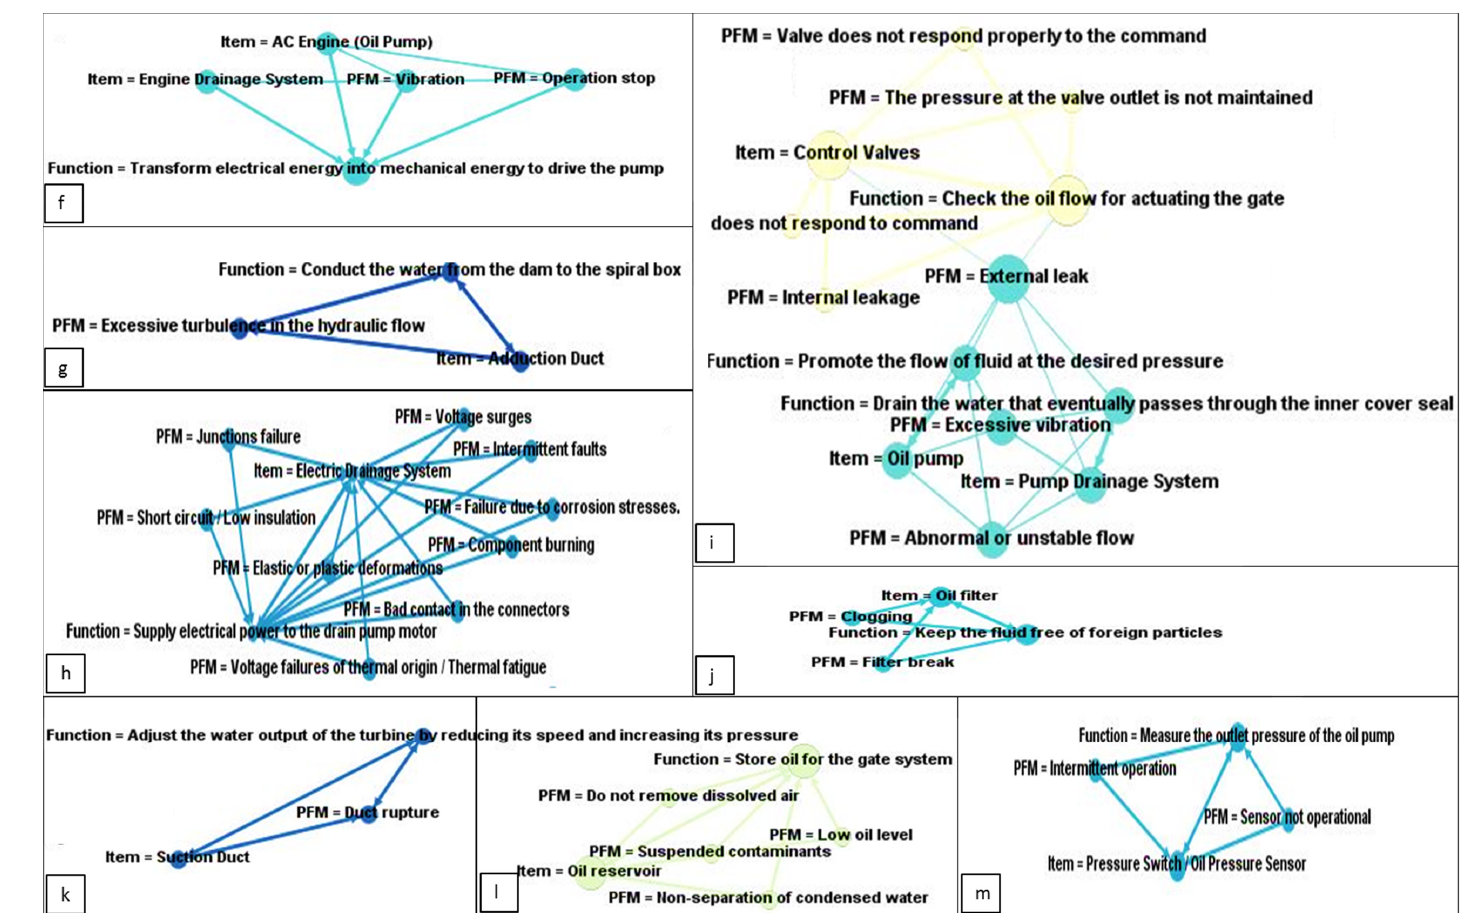
Figure 1. Social Network representing the relationships between Item, Potential Failure Mode (PFM) and Functions of the turbine system: ( a – m ); represent the thirteen communities of nodes originated from the analysis.